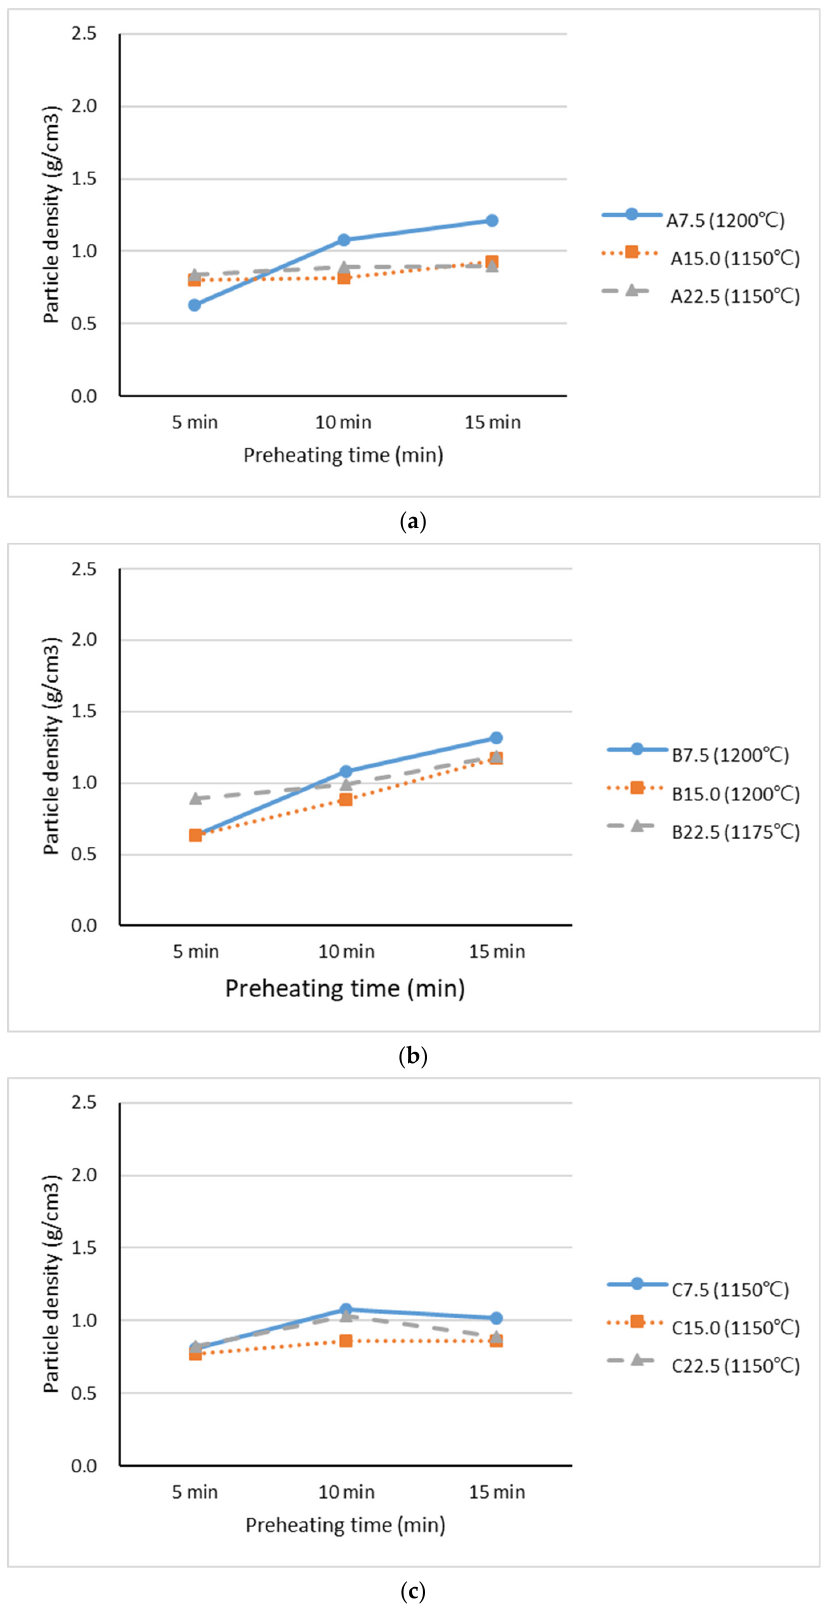
Figure 6. Particle density of lightweight aggregates at Stage II mixed with ( a ) Industrial Sludge A, ( b ) Industrial Sludge B, and ( c ) Industrial Sludge